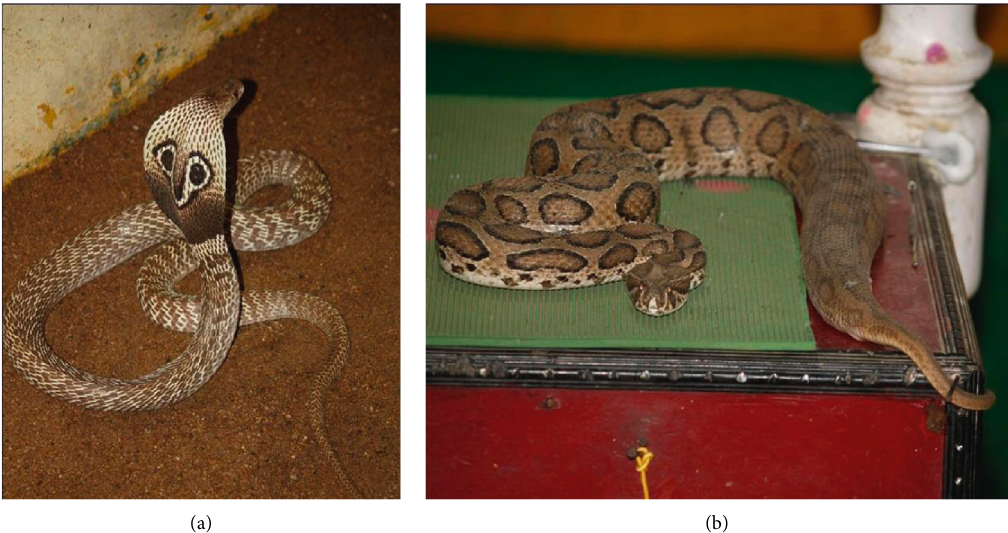
Figure 1: (a) Indian cobra (Naja naja) and (b) Russell’s viper (Daboia russelii) (pictures were captured by one of the authors on 21 March